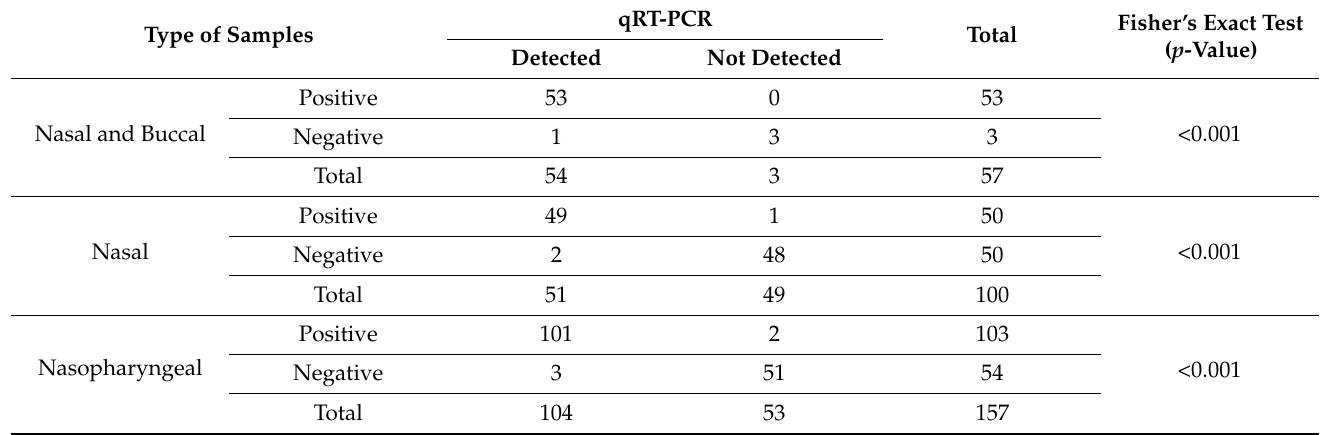
Table 4. Association of different tested samples in comparison to RT-PCR as a reference